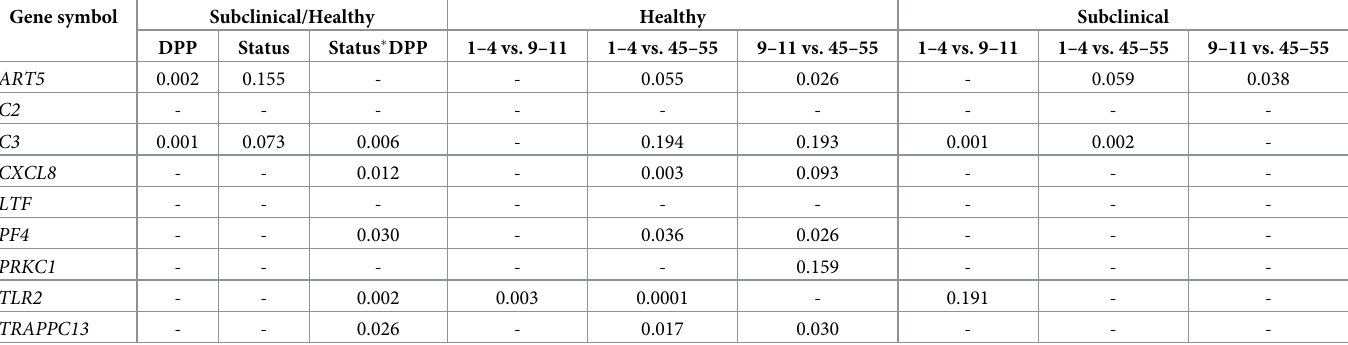
Table 1. Temporal gene expression analyses (RT-qPCR) of selected candidate gene in circulating white blood cells of cows with subclinical endometritis during the post-partum period.